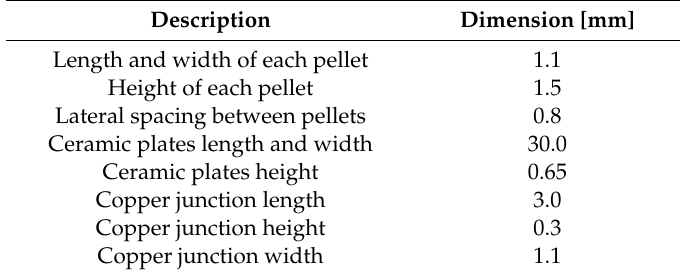
Table 1. Dimensions of the thermoelectric module TEHP 1263-1.5 (Thermonamic) [20].